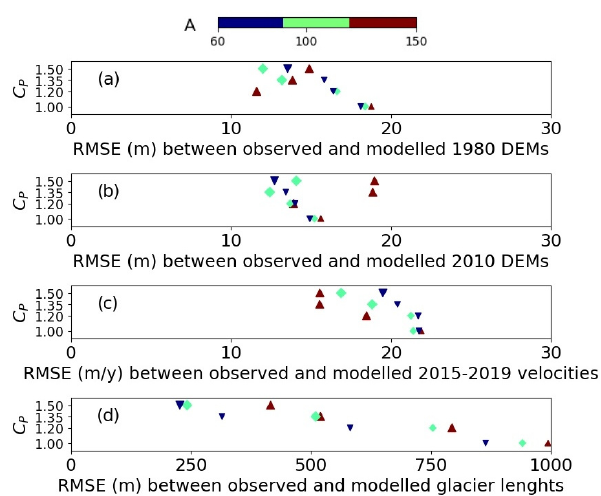
Figure 7. Root mean square error (RMSE) between modeled and observed variables for the 12 model runs (indexed by C P and A ) relating to the 1980 DEM (a) , the 2010 DEM (b) , the 2015–2019 surface velocities (c) and the length of the glacier tongue (d) . Large (or small) symbols indicate the parameter sets that yield realistic (or unrealistic) results and then were kept (or discarded) for analysis (Fig.